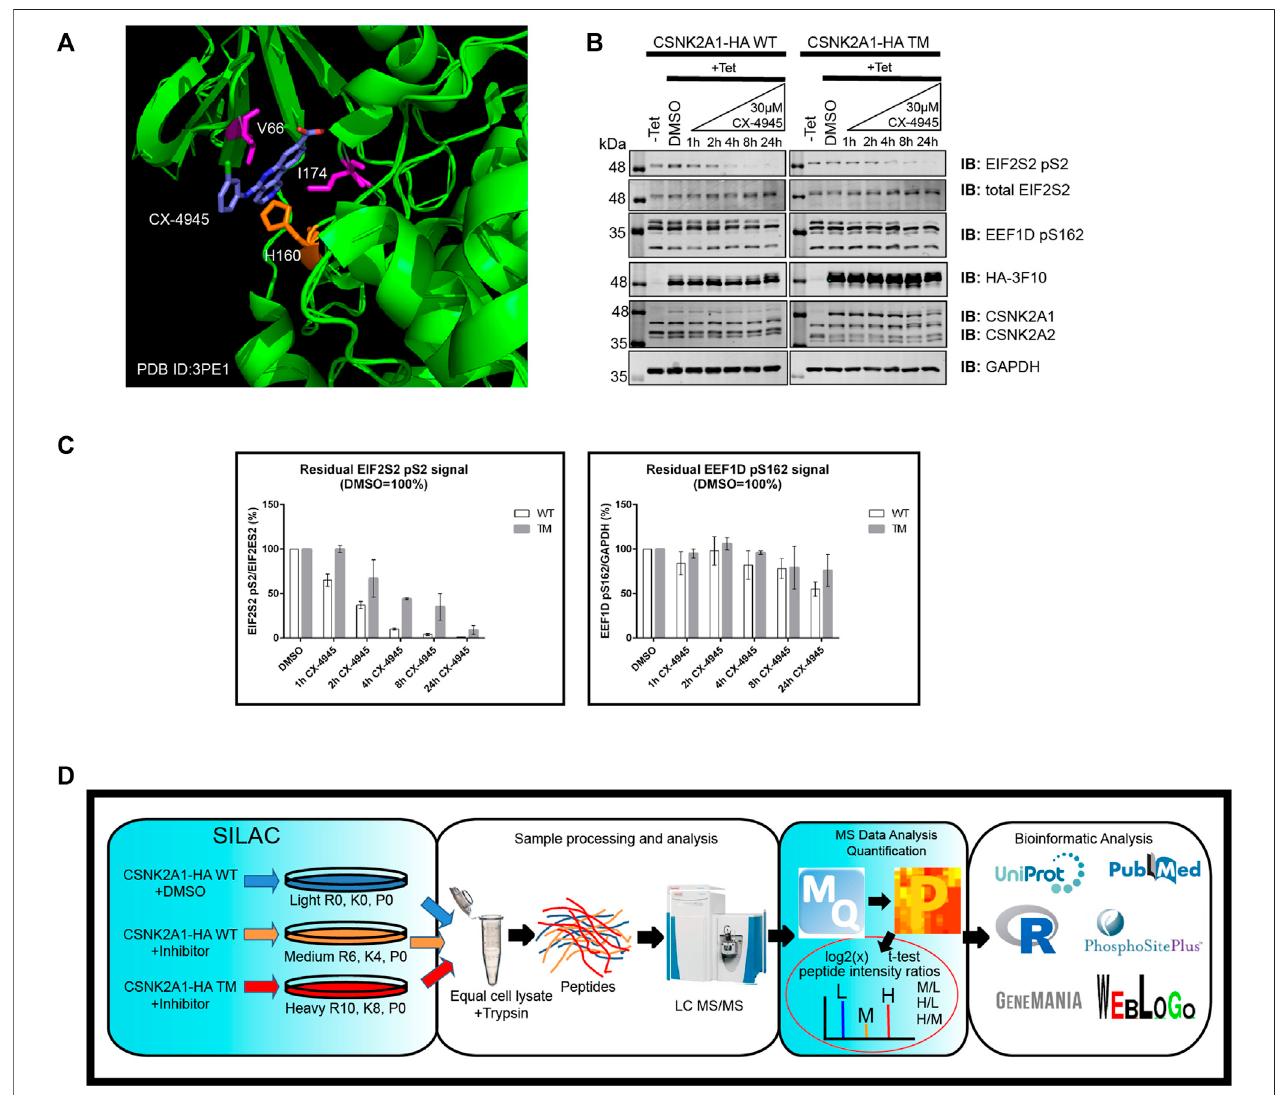
FIGURE2| UseofatriplemutantCSNK2A1forvalidationofCSNK2substrates. (A) CrystalstructureofCX-4945interactingwiththeATP-bindingsiteofCSNK2A1 (PDB ID: 3PE1). Highlighted are the residues mutated in CSNK2A1-TM (V66A/H160D/I174A) to create an inhibitor tolerant/resistant kinase. (B) Immunoblots demonstratetheinhibitionandrescueofCSNK2-dependentphosphorylationusingFlp-InT-RExU2OScelllinesstablyexpressingCSNK2A-HAWTorCSNK2A-HATM with tight Tetracycline (Tet-ON) regulation. Cells were treated with 30 µM of CX-4945 for the indicated times. (C) Bar charts demonstrate residual CSNK2 activity basedonEIF2S2pS2/totalEIF2S2orEEF1DpS162/GAPDHratios,withCSNK2activityintheDMSOcontrolde fi nedas100%.Eachcolumnrepresentsthemeanvalue oftwoindependentexperimentswithrangebarsdisplayed.Bandintensitiesonblotswerequanti fi edwithLiCorOdysseyv3.0software.Resultsarerepresentativeoftwo independent experiments (D) Overview of large-scale identi fi cation and validation ofCSNK2 substrates using a chemical genetics approach combined with triple SILAC quantitative